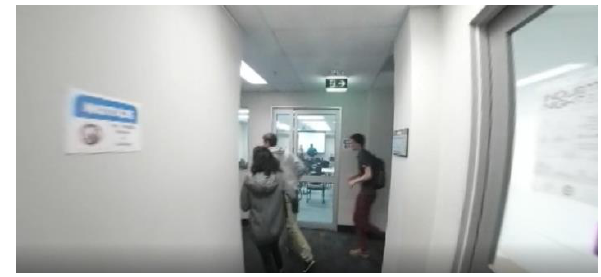
Figure 6. Scenario 2 still shot as viewed through VR